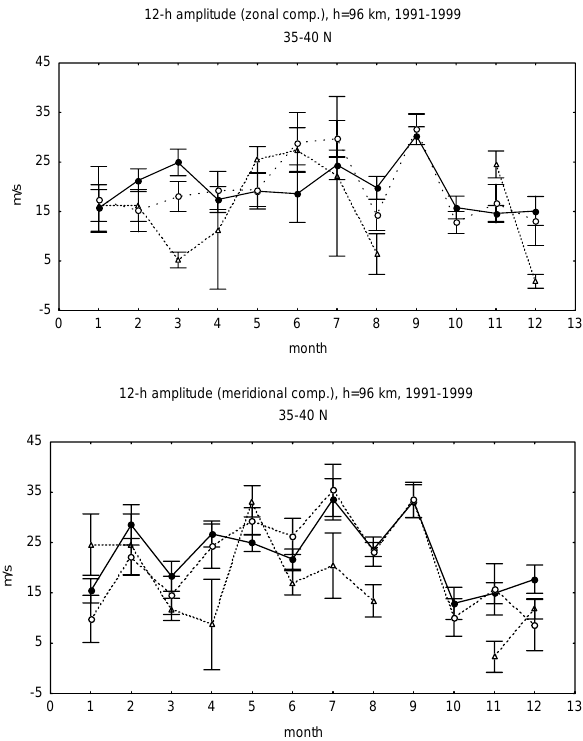
Fig. 5. Same as Fig. 2, except for amplitude of semidiurnal